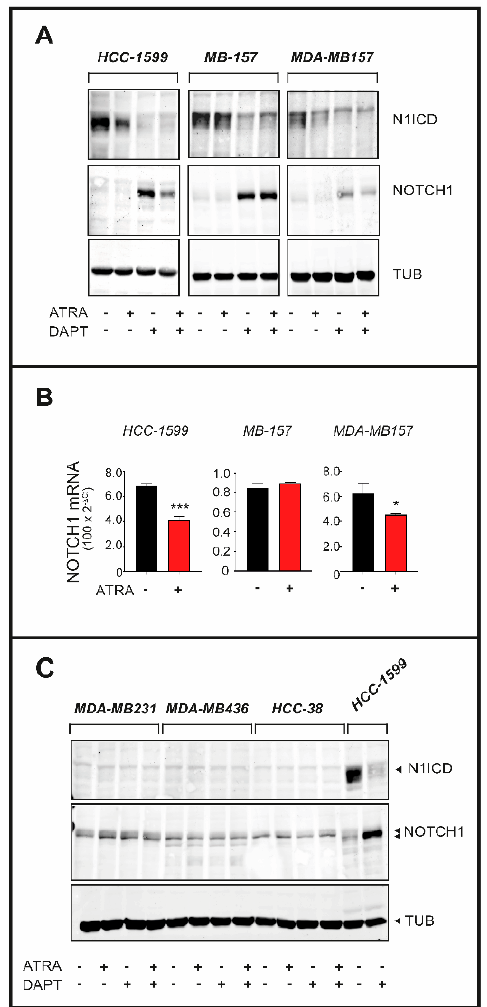
Figure 5. Effects of ATRA and DAPT on the expression of N1ICD and NOTCH1 in retinoid sensitive and retinoid insensitive TNBC cell lines ( A ) HCC-1599, MB-157 and MDA-MB157 cells were treated with vehicle (DMSO), ATRA (1 µ M), DAPT (1 µ M) or the combination of the two compounds for 24 h. Whole cell lysates were subjected to Western blot analysis for the detection of the NOTCH1 protein and the γ -secretase cleaved N1ICD product using specific antibodies. The same amount of protein was loaded in each lane and the filters were re-blotted with anti-tubulin antibodies, as indicated. The densitometric analyses of the Western blots presented are available in Figure S8. ( B ) RNA extracted from the indicated cell lines exposed to vehicle (DMSO) or ATRA (1 µ M) for 24 h was subjected to RT-PCR analysis using a quantitative SYBR green assay for the detection of the NOTCH1 mRNA. The results are the mean + SD of three replicate cell cultures. *** Significantly di ff erent ( p < 0.01, Student’s t -test). * Significantly di ff erent ( p < 0.05, Student’s t -test). ( C ) MDA-MB231, MDA-MB436 and HCC-38 cells were treated with vehicle (DMSO), ATRA (1 µ M), DAPT (1 µ M) or the combination of the two compounds for 24 h. Lysates were subjected to Western blot analysis for the detection of the NOTCH1 protein and the γ -secretase cleaved N1ICD product using specific antibodies as in ( A ). HCC1-599 cells were used as an internal control of the experiment. The densitometric analyses of the Western blots presented are available in Figure